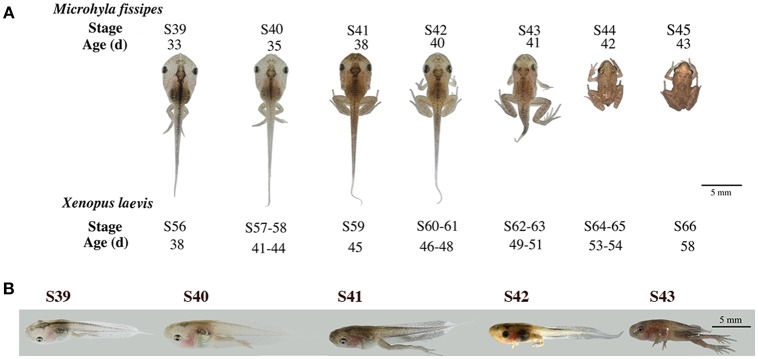
Morphological changes associated with tail resorption during M. fissipes metamorphosis. (A) A representative M. fissipes animal at indicated developmental stages from S39 (around the onset of metamorphosis) to S45 (end of metamorphosis) is shown together with typical age (in days, d) of the animal when reared at 22.9–25.4°C. Shown at the bottom are the corresponding stages of X. laevis animals and their ages when reared at 22–24°C (28), scale bar: 5 cm. (B) Lateral views of the tail at indicated developmental stages.